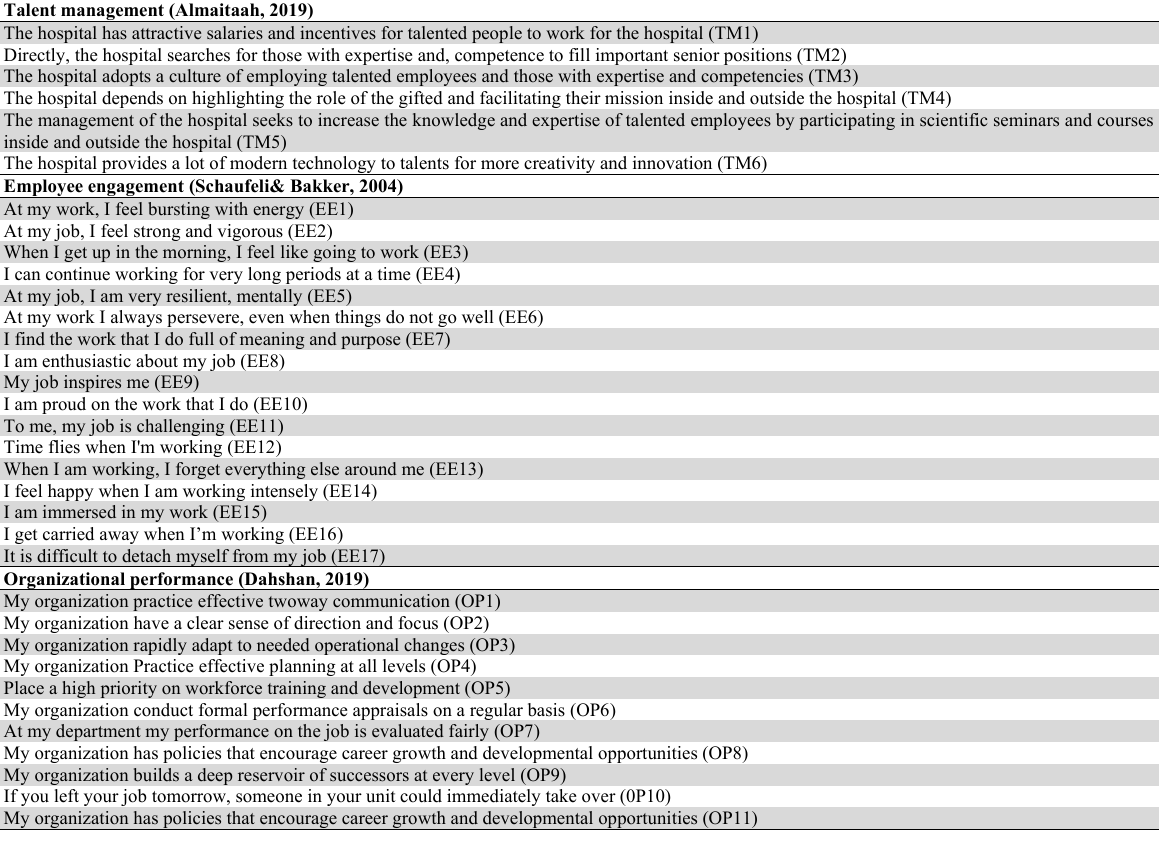
Description of Variables